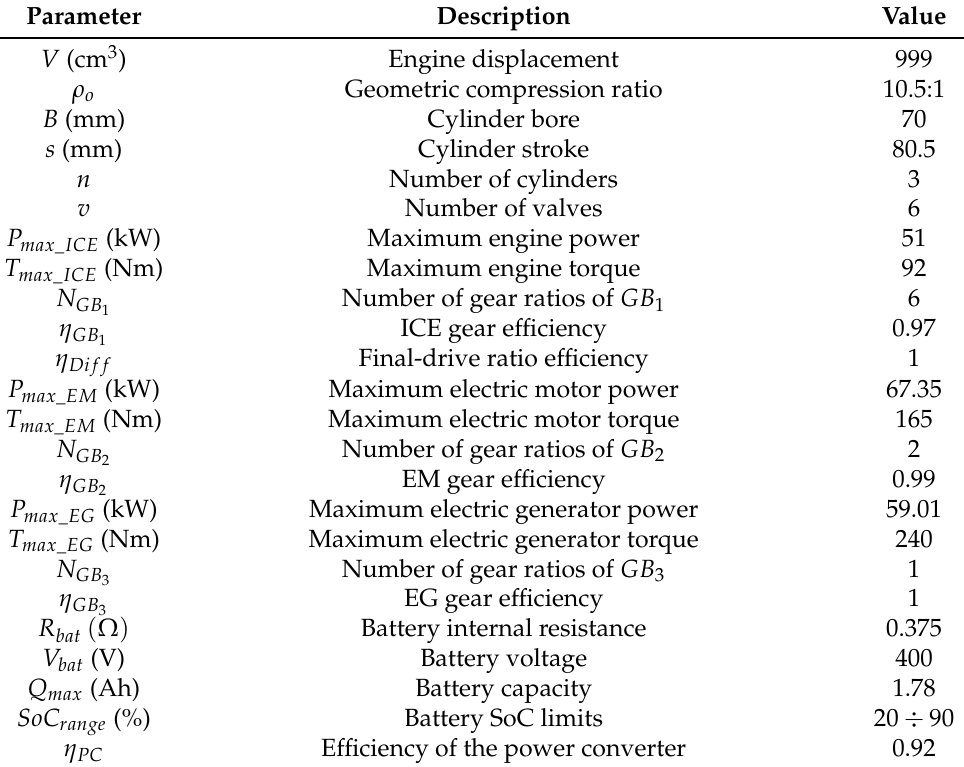
Table 3. Powertrain and driveline main